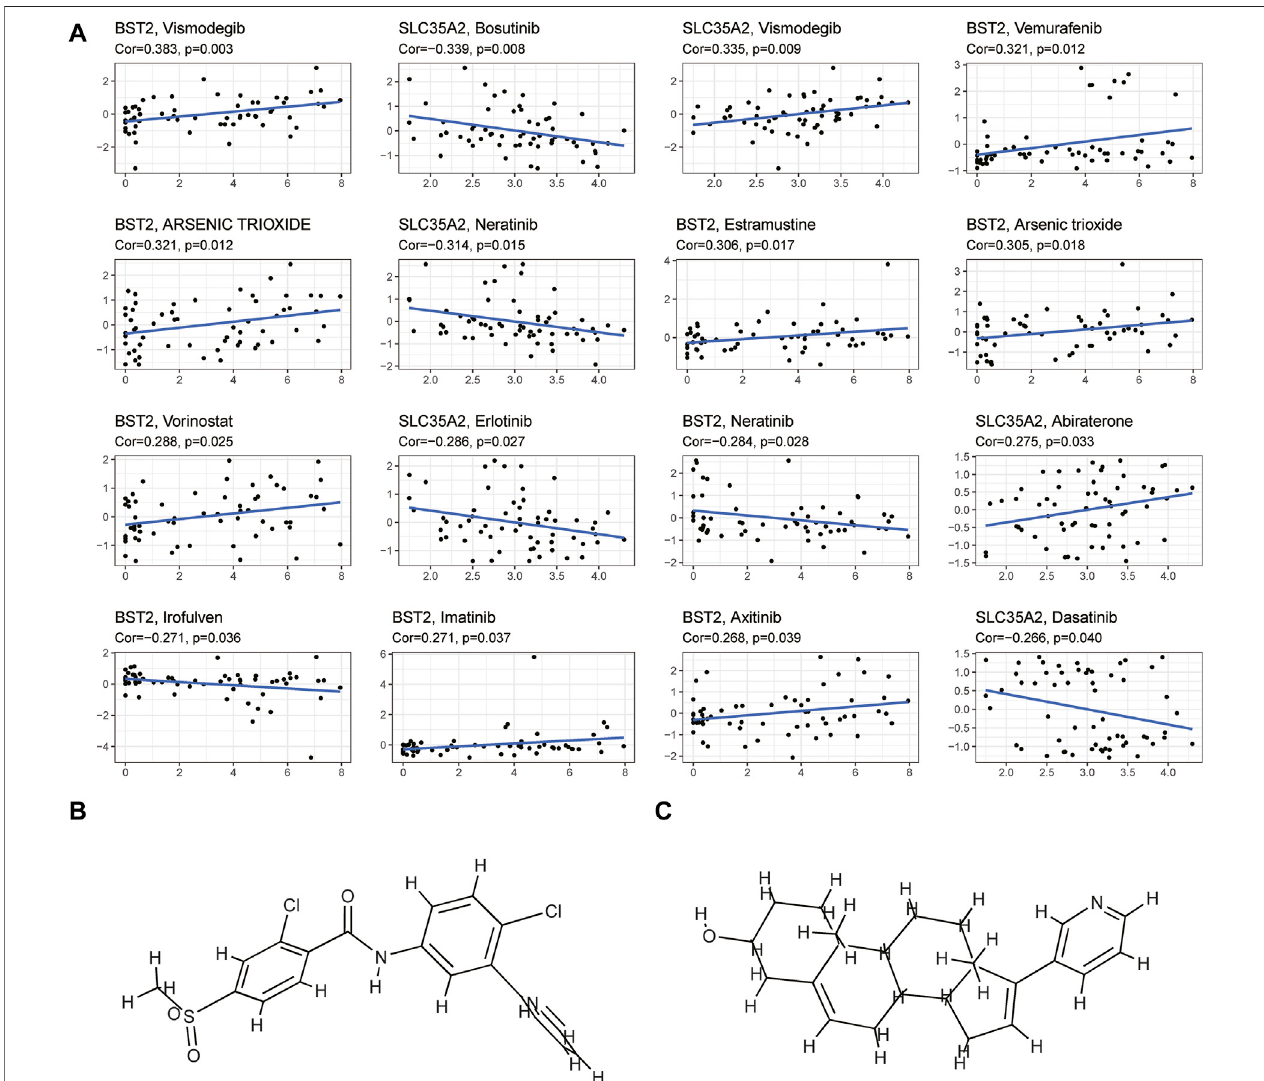
FIGURE 12 | Drug sensitivity analysis (A) The plot showed the correlation between the expression levels of key genes in the model and cell sensitivities to certain drugs( p < 0.05) (B,C) Theplotshowedthethree-dimensionalstructureoftwodrugs(VismodegibandAbiraterone)whosesensitivitieswerepositivelycorrelatedwiththe expression of SLC35A2